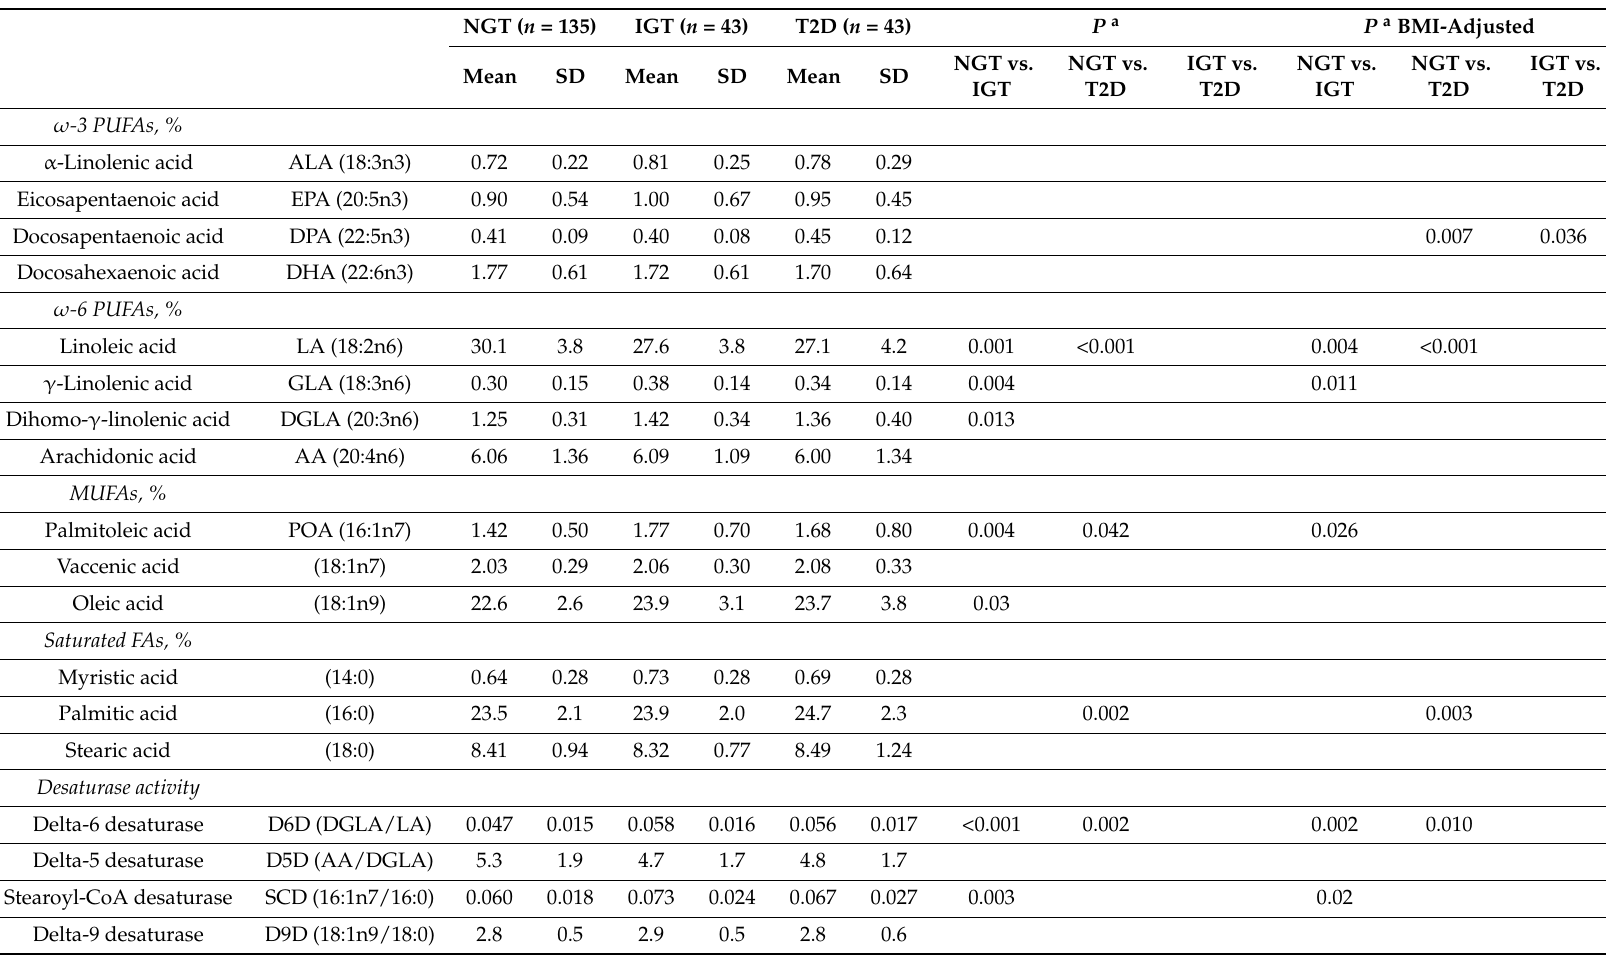
Table 3. Serum fatty acid (FA) composition 6 years after GDM, expressed as % of total FAs. Women were divided in glucose tolerance groups based on OGTT at 6 year visit; type 2 diabetes (T2D) was determined by OGTT at time of diagnosis or at 6-year